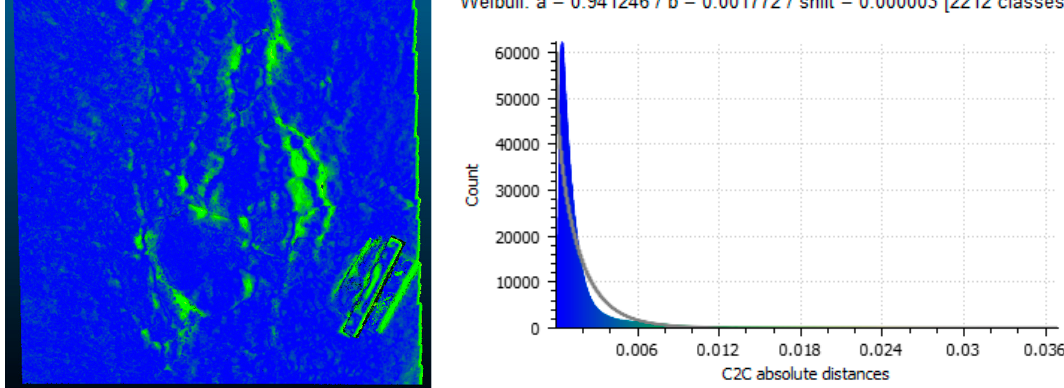
Figure 16. Measured differences between model generated by the camera and Huawei phone, ( right )—visualization of differences projected on model, ( left )—distribution of measured differences.